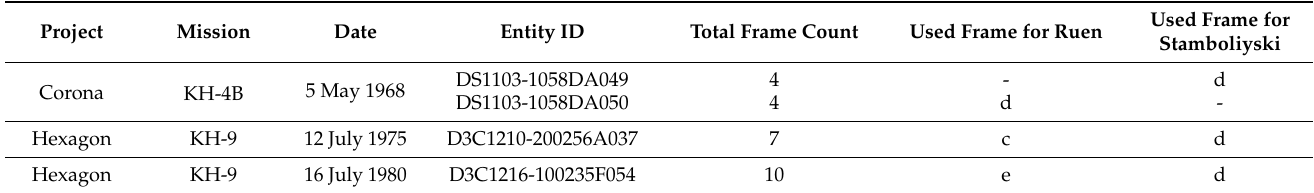
Table 2. Information about the satellite imageries used in the study, the number of Corona and Hexagon image subsets, and the used frame for covering the Ruen and Stamboliyski study sites.